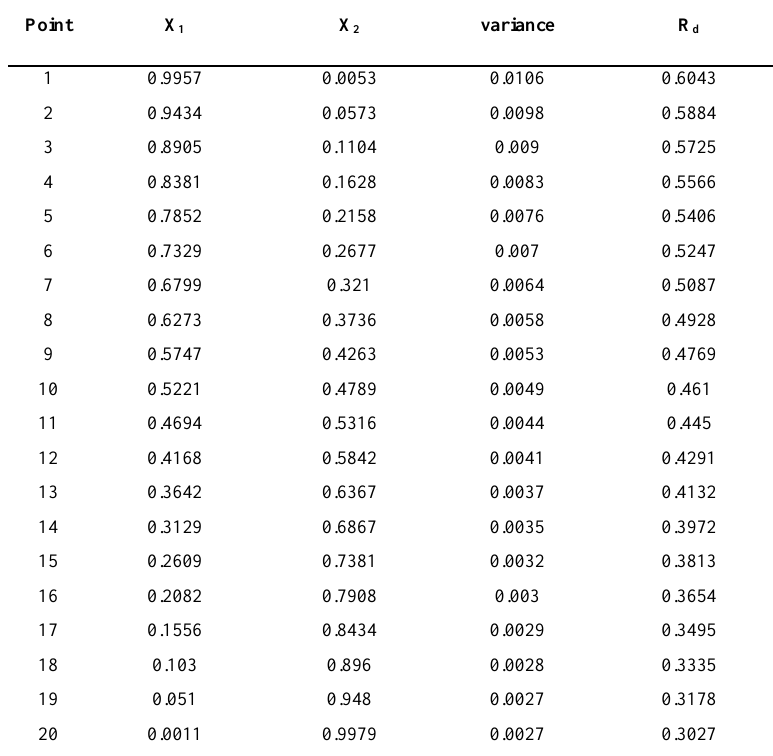
Table1. Portfolio forming the efficient